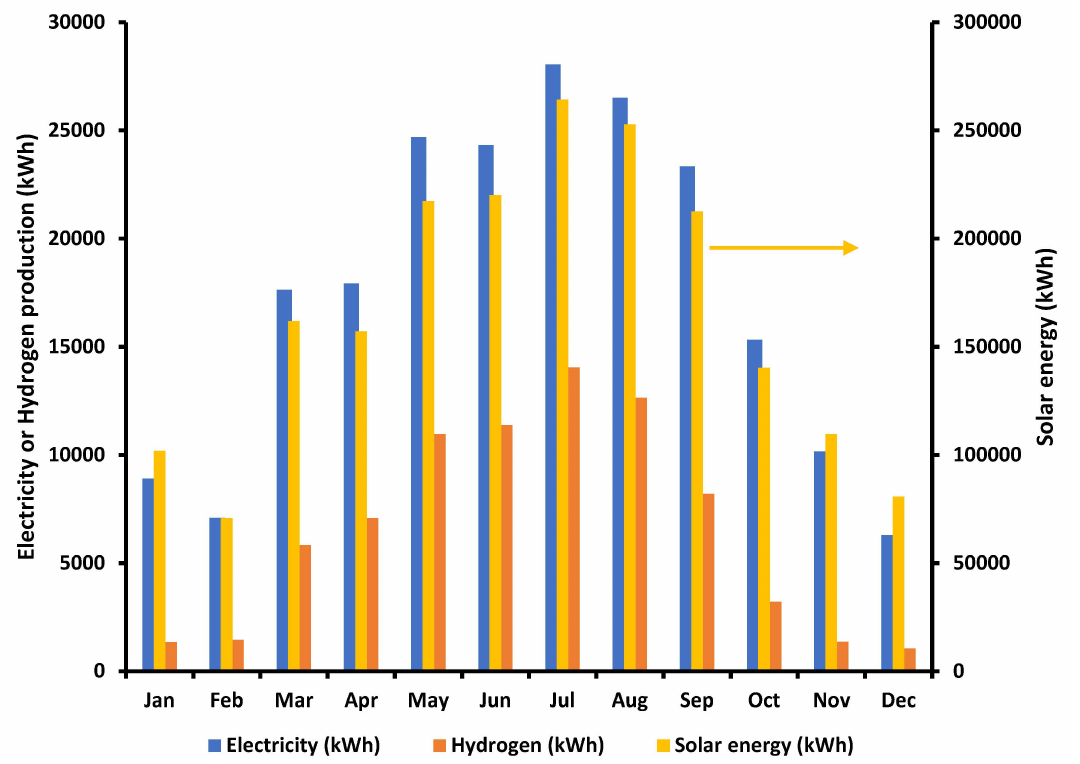
Figure 19. Monthly electricity production, hydrogen energy production, and available solar